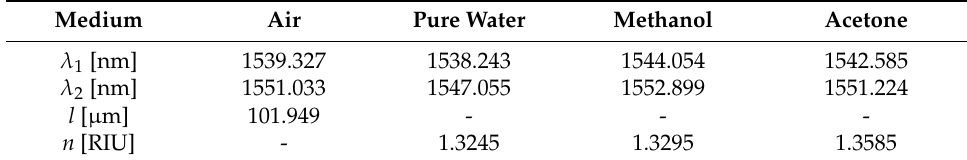
Table 1. Values of two adjacent interference minima and values of the RIs (at 20 ˝ C)